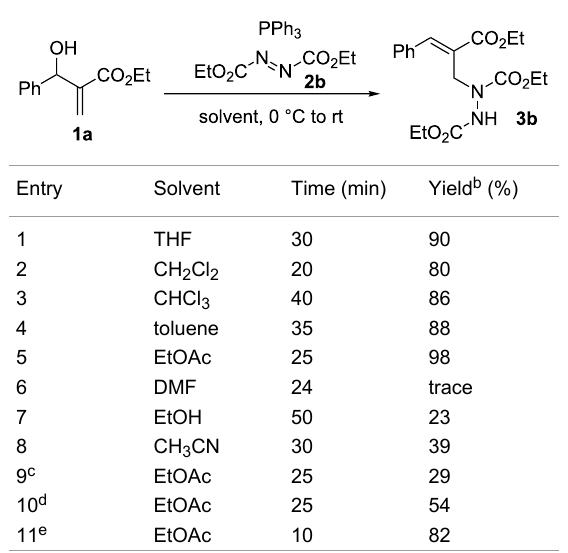
Table 1: Investigation on reaction conditions. a